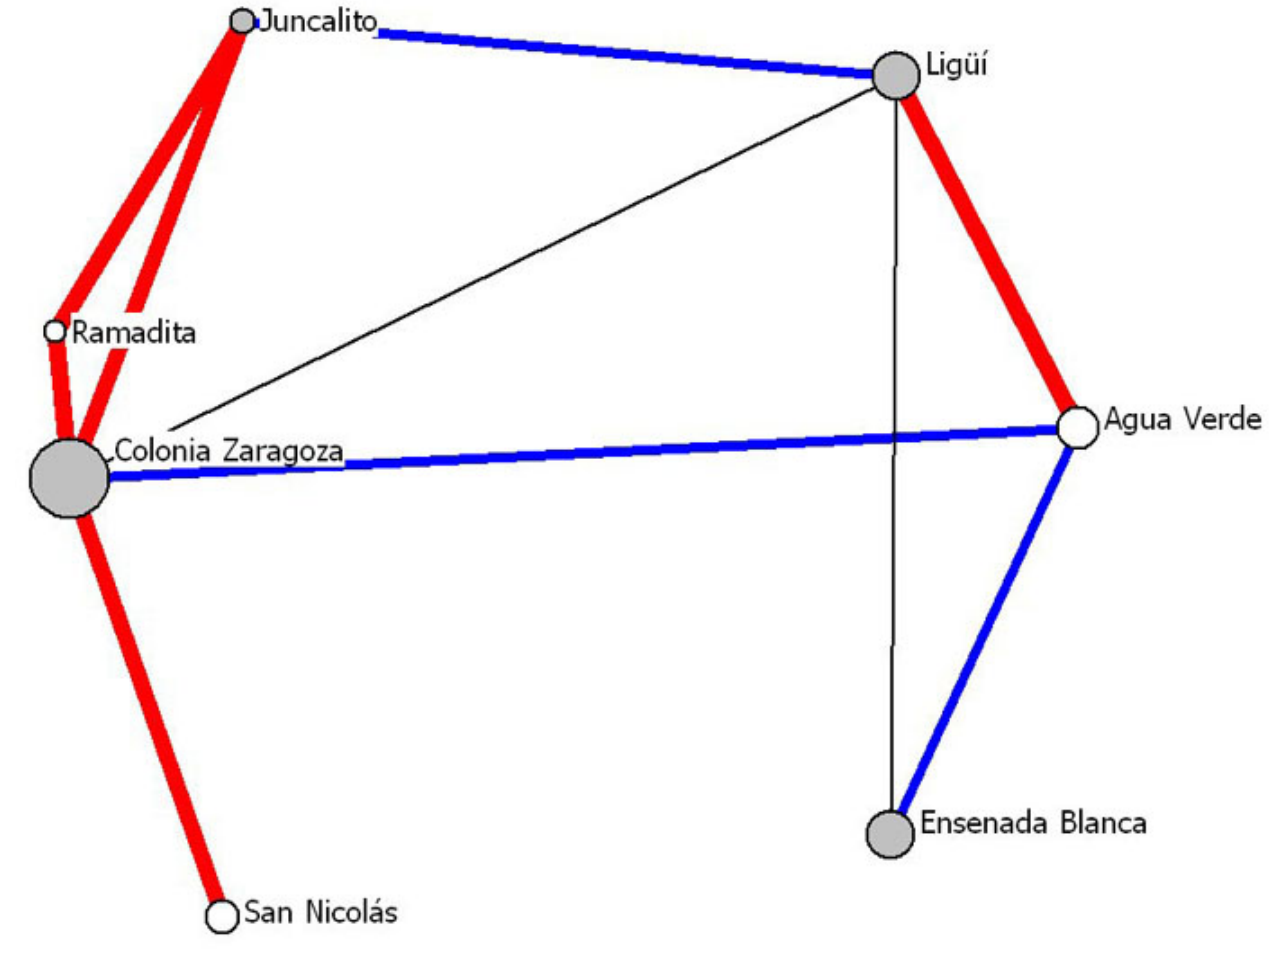
Fig. 8. Multi-dimensional scaling plot showing the acquaintance linking structure among the seven communities. The size of each node (community) is proportional to the number of fishers considered in each community; communities with high resource scarcity are shown with gray circles and communities with low resource scarcity are shown with white circles. The thickness of intercommunity links is proportional to the ratio of the measured vs. the expected number of relations. Thin line < 0.5 in black, medium line < 1 in blue, thick line > 1 in red. Ratio values less than 0.1 were